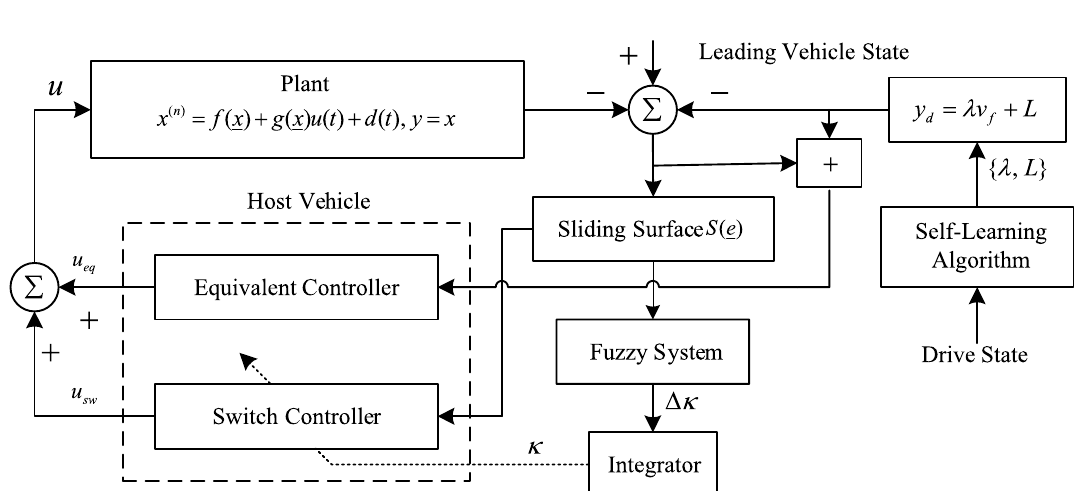
Figure 4. Block diagram of the slip model control system for a driver longitudinal following behavior